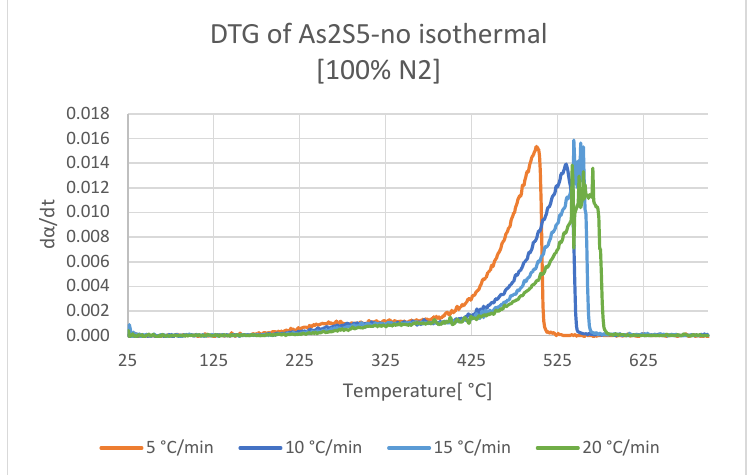
Figure 3. DTG for different heating rates in inert atmosphere. [own elaboration].